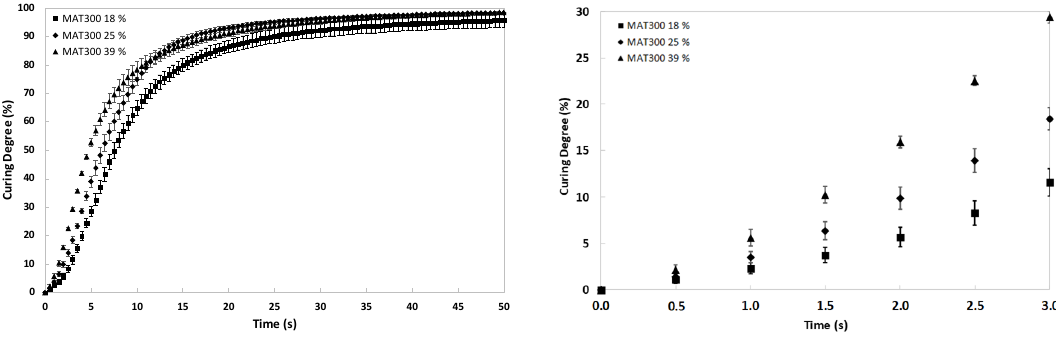
Figure 10. ( Left ) Curing degree of MAT300 with 18 ( ■ ), 25 ( ♦ ), and 39 wt.% ( ▲ ) fibre contents. ( Right ) Magnification from 0 to 3 s time of curing.